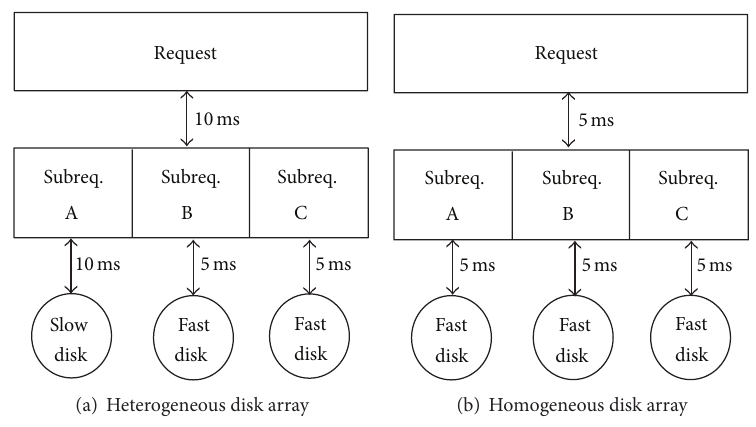
Figure 1: The typical I/O request in heterogeneous and homogeneous disk array, respectively.